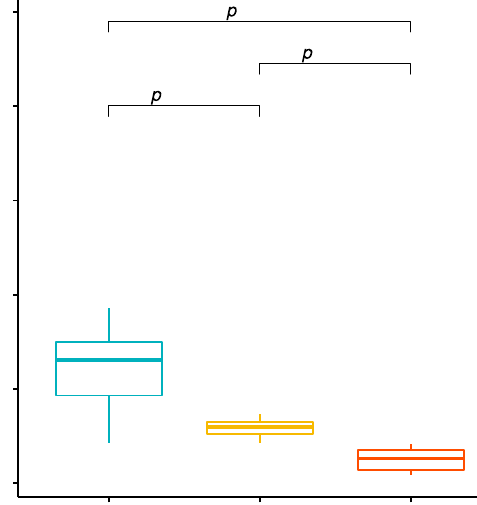
Figure 1. Percentages of CD4 +/ TLR-2 + T lymphocytes (among CD4 + cells) in patients with Graves’ disease (GD) before treatment, after euthyroidism and in the control